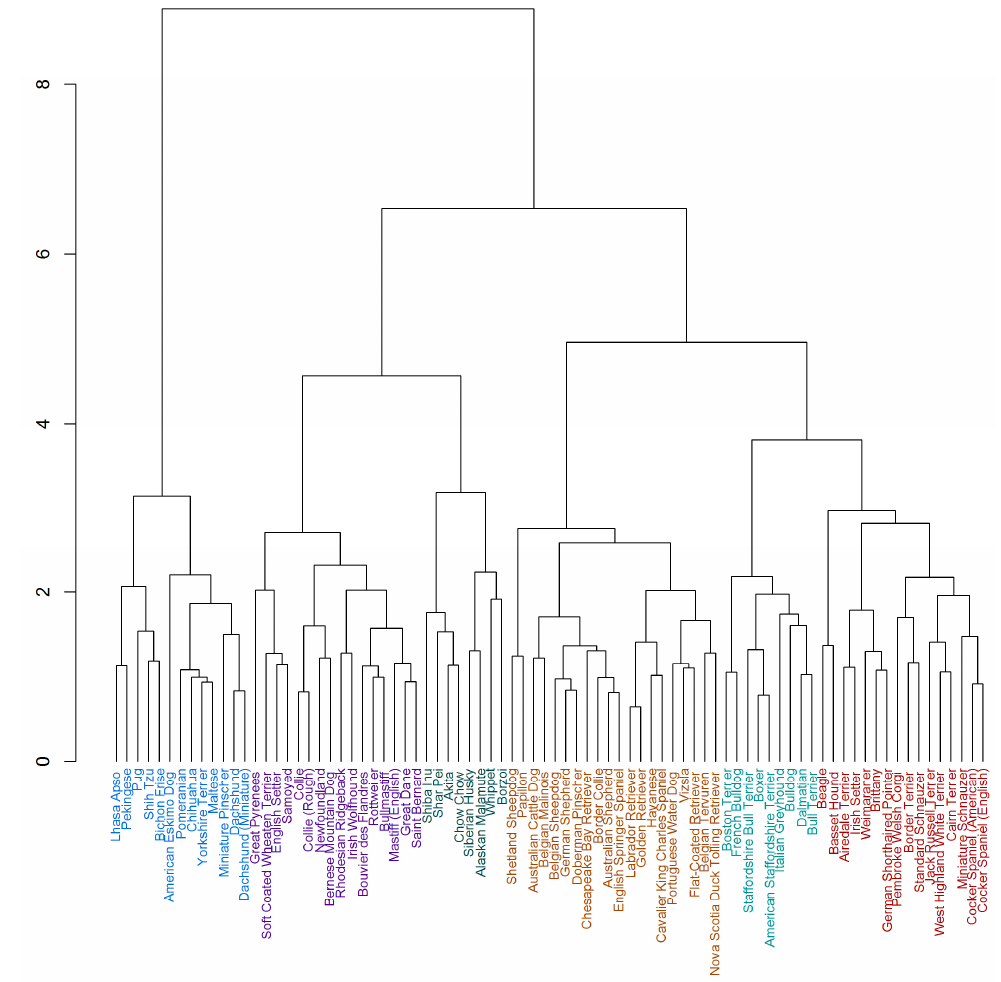
Figure 1. Dendrogram from Agglomerative Hierarchical Cluster analysis of C-BARQ behavioural subscales and miscellaneous behaviours for arithmetic means of 82 breeds. Division into six clusters is shown.